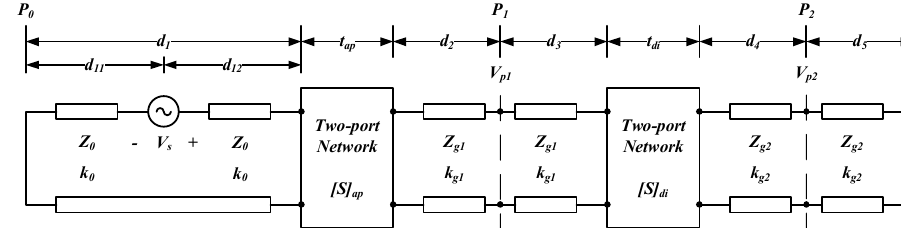
Figure 1. Physical model of irregular shielded cavity irradiated by plane waves. Based on the electromagnetic topology theory, the above physical model is recon- structed as an equivalent transmission line network with tubes and nodes. The equivalent circuit diagram and the corresponding signal flow diagram are shown in Figures 2 and 3, respectively: